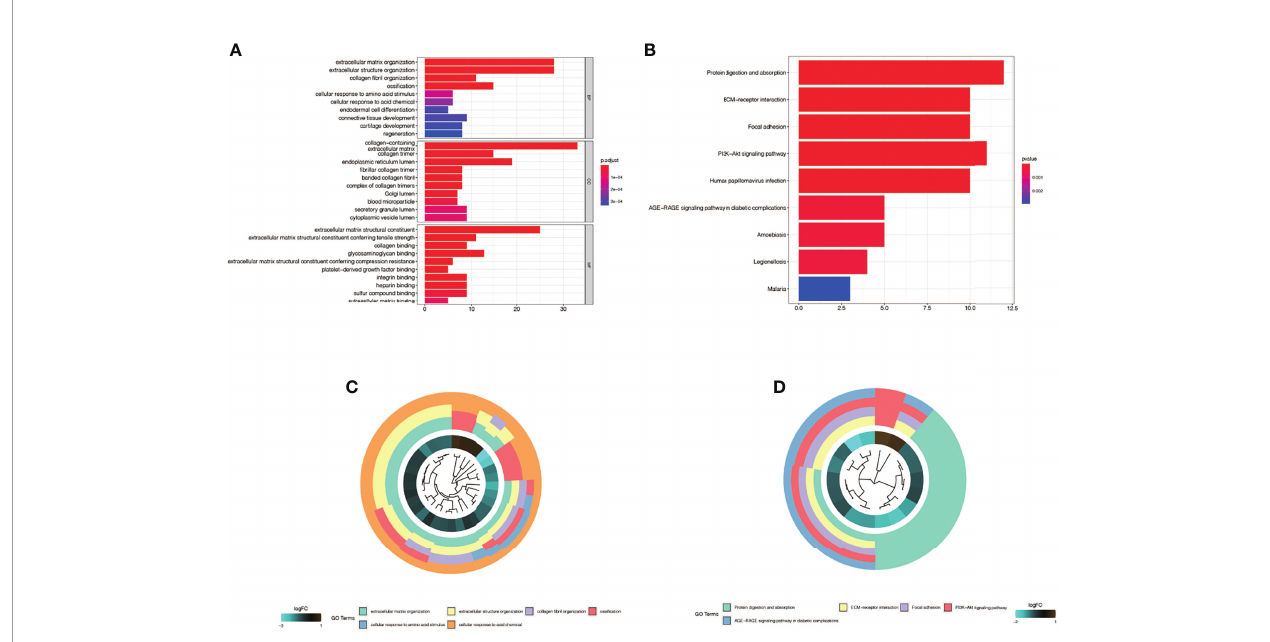
FIGURE 4 | Enrichment analysis in the single-cell dataset GSE163973. (A) The Gene ontology (GO) enrichment. The results were divided into biological process (BP), cell component (CC) and biological function (MF). (B) Kyoto Encyclopedia of Genes and Genomes enrichment (KEGG). (C) The fi rst fi ve most signi fi cant GO enrichment results are shown in a circle graph. (D) The fi rst fi ve most signi fi cant KEGG enrichment results are shown in a circle